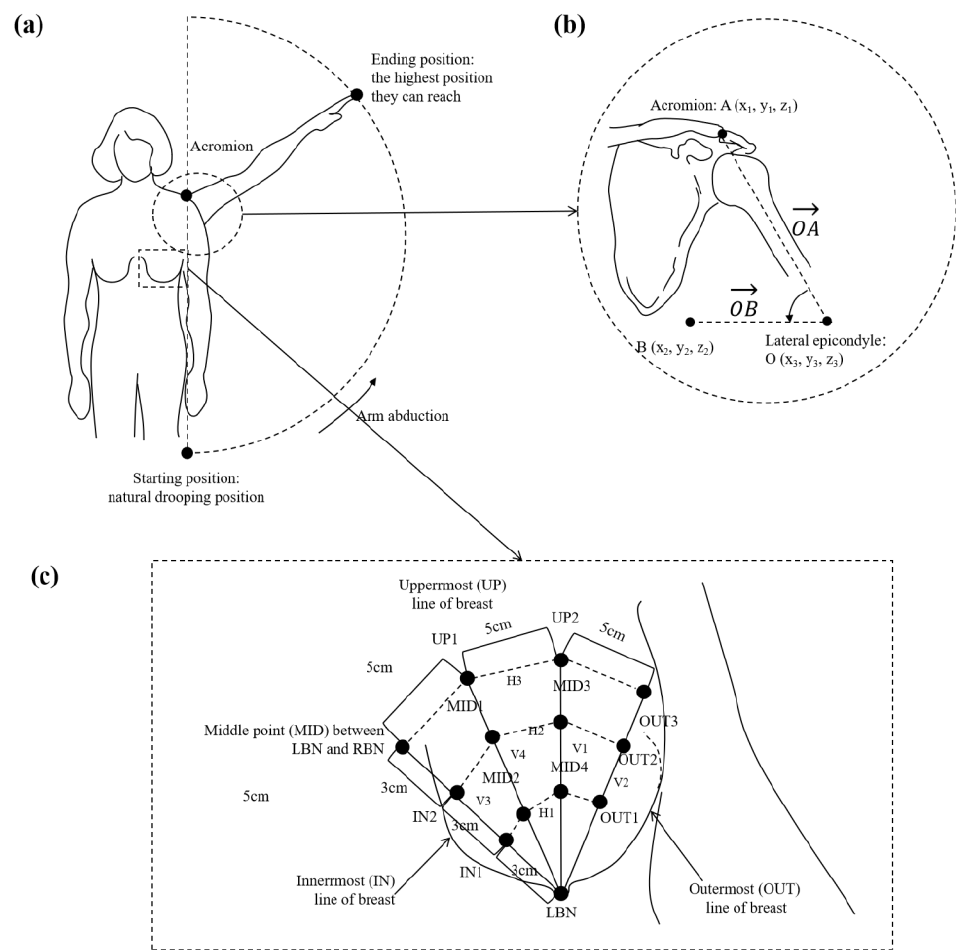
Figure 2. ( a ) The illustration of the posture during the motion data collection; ( b ) during the arm abduction process, the calculation of the arm abducting angle used in this study, which is the included angle between the vector OA and vector OB; ( c ) the definition of the markers on breast